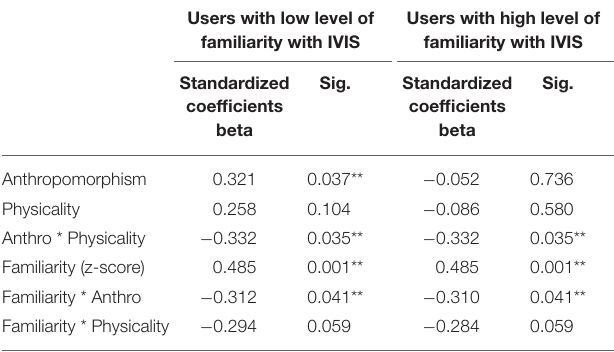
TABLE 4 | Spotlight analyses for users’ familiarity with IVIS ( + /-SD) on cognitive trust. Users with low level of familiarity with